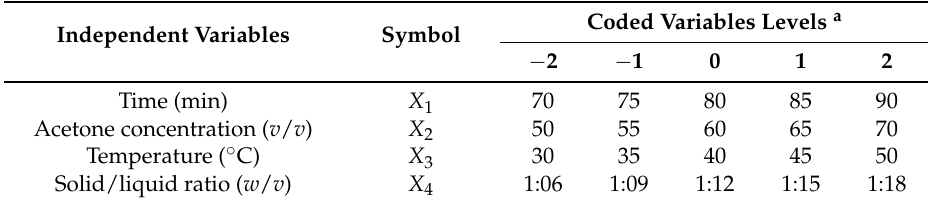
Table 1. Independent variable values of the kiwi fruit seed polyphenols (KSP) extraction process and their corresponding